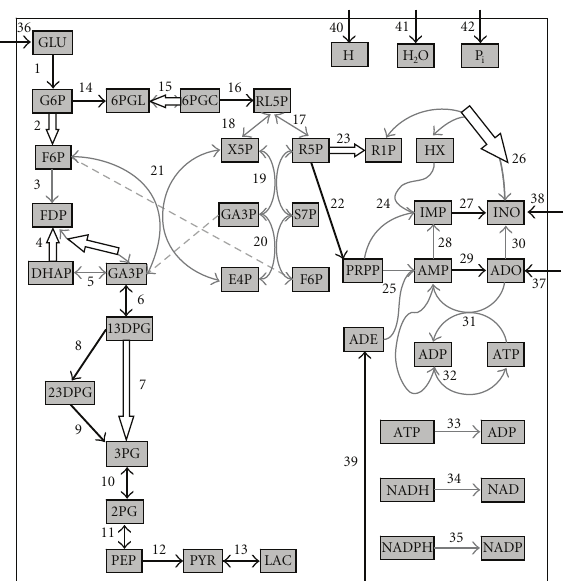
Figure 3: hRBC’s structural reaction replaceability map. Thick black arrows denote unreplaceable reactions (group (b) above); thick white-filled arrows denote reversible reactions that can be replaced only in the direction indicated by the arrow (group (c)); all other reactions are fully replaceable (group